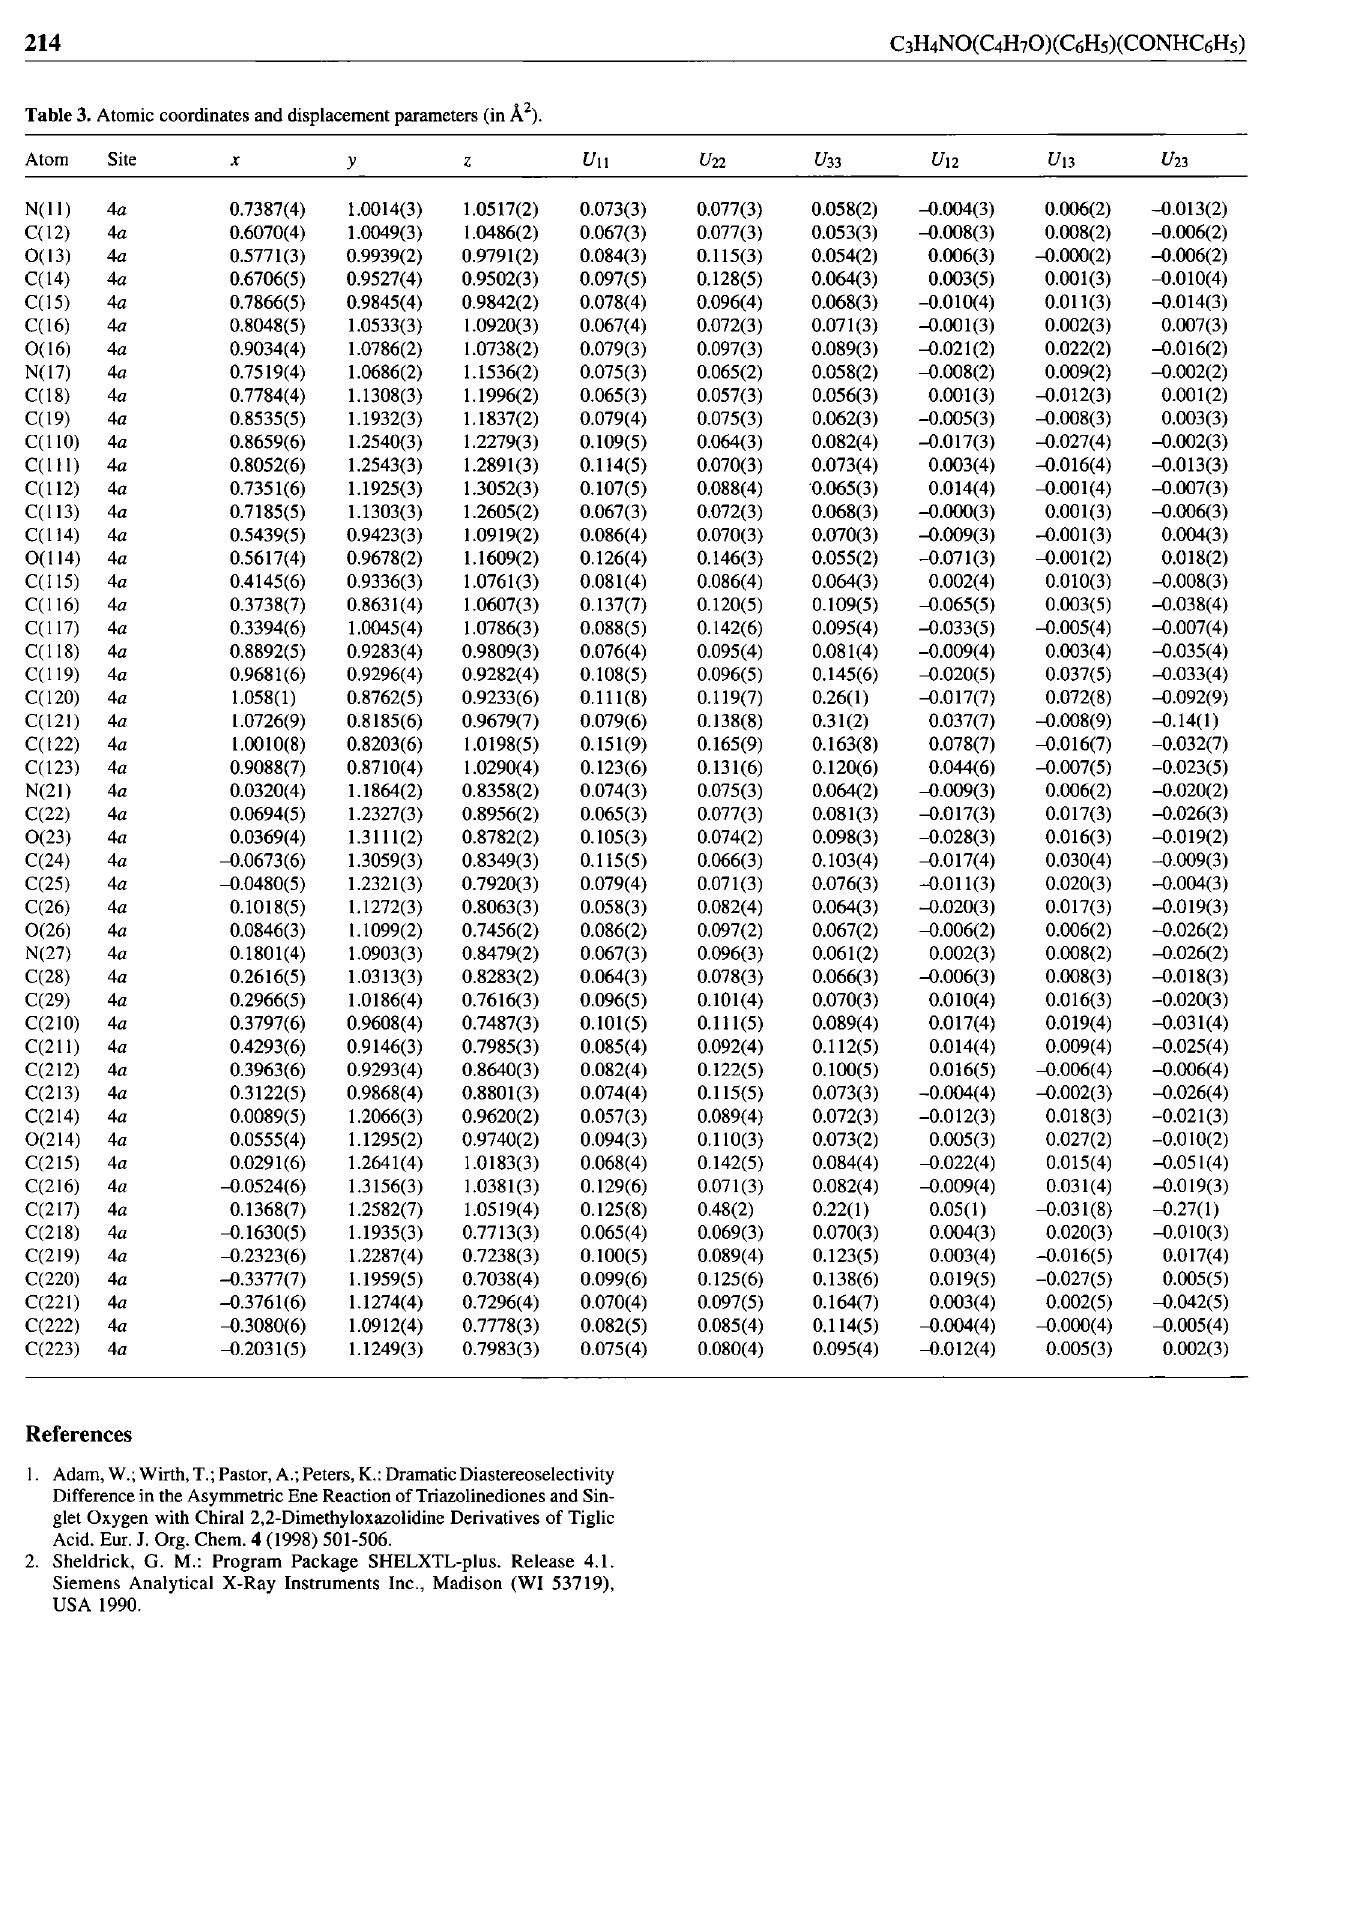
Table 3. Atomic coordinates and displacement parameters (in Ä 2